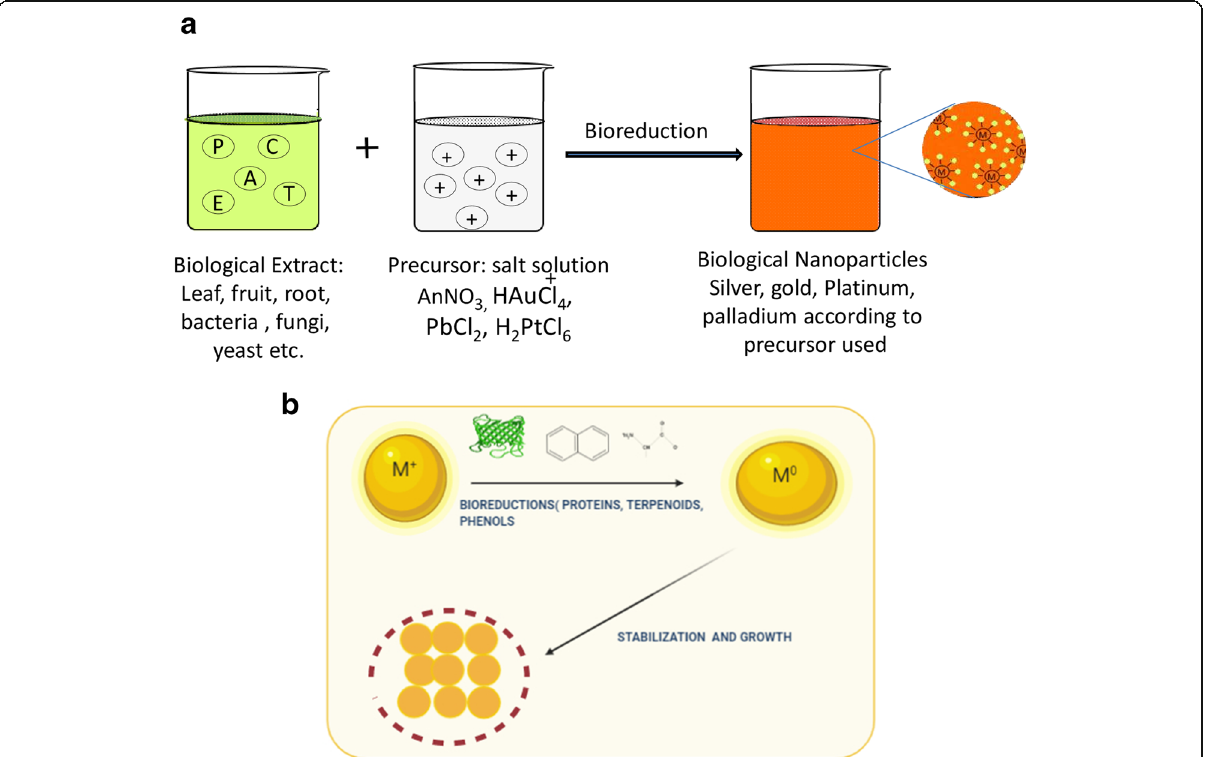
Fig. 3 a Biological synthesis of nanoparticles. b Mechanism of plant-mediated metallic nanoparticles